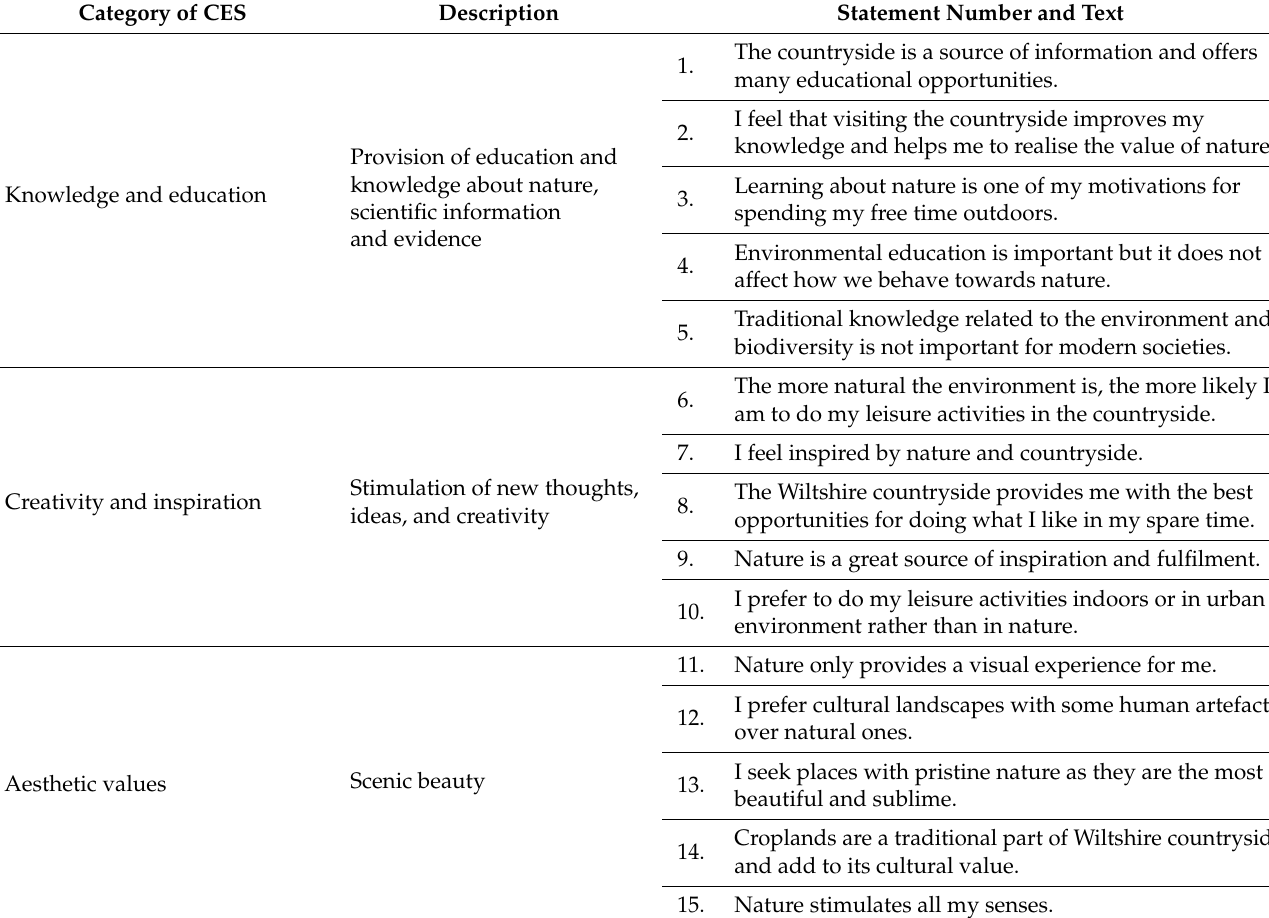
Table 1. Categories of CES identified for the CES concourse in